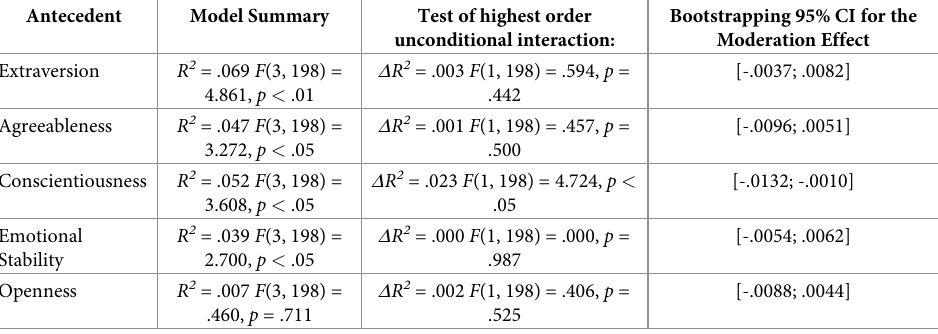
Table 3. Alternative models summaries and